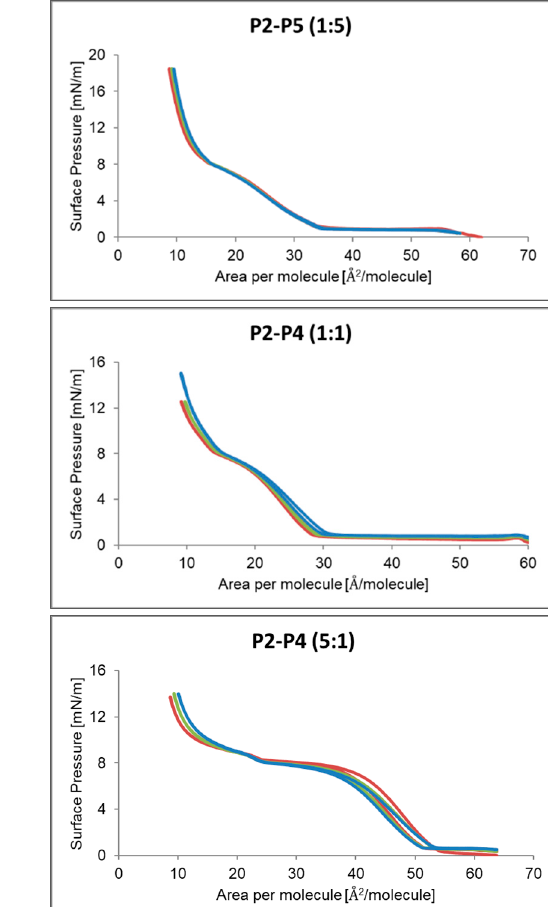
Figure 8. Hysteresis of the mixtures P2, P4, P5 peptide in different proportion. Loop 1 ( - ), Loop 2 ( - ), Loop 3 ( - ).